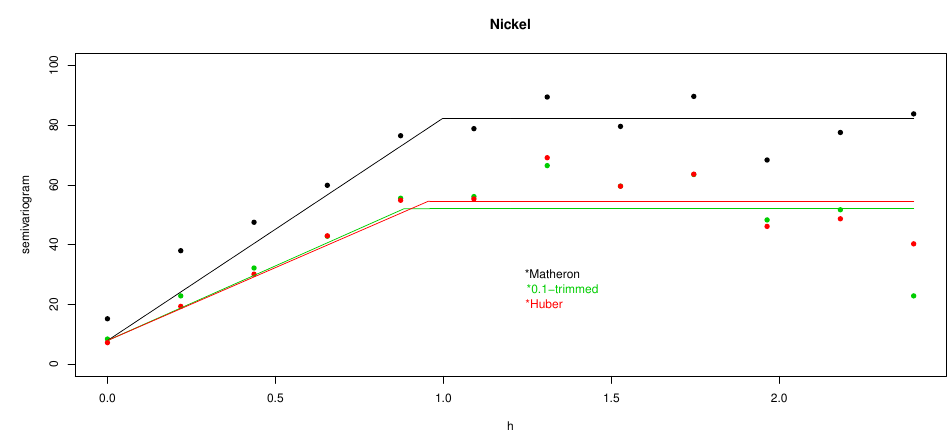
Figure 8. Classical (black) and robust (green and red) variogram estimations for nickel and their linearized variograms of Example 2.